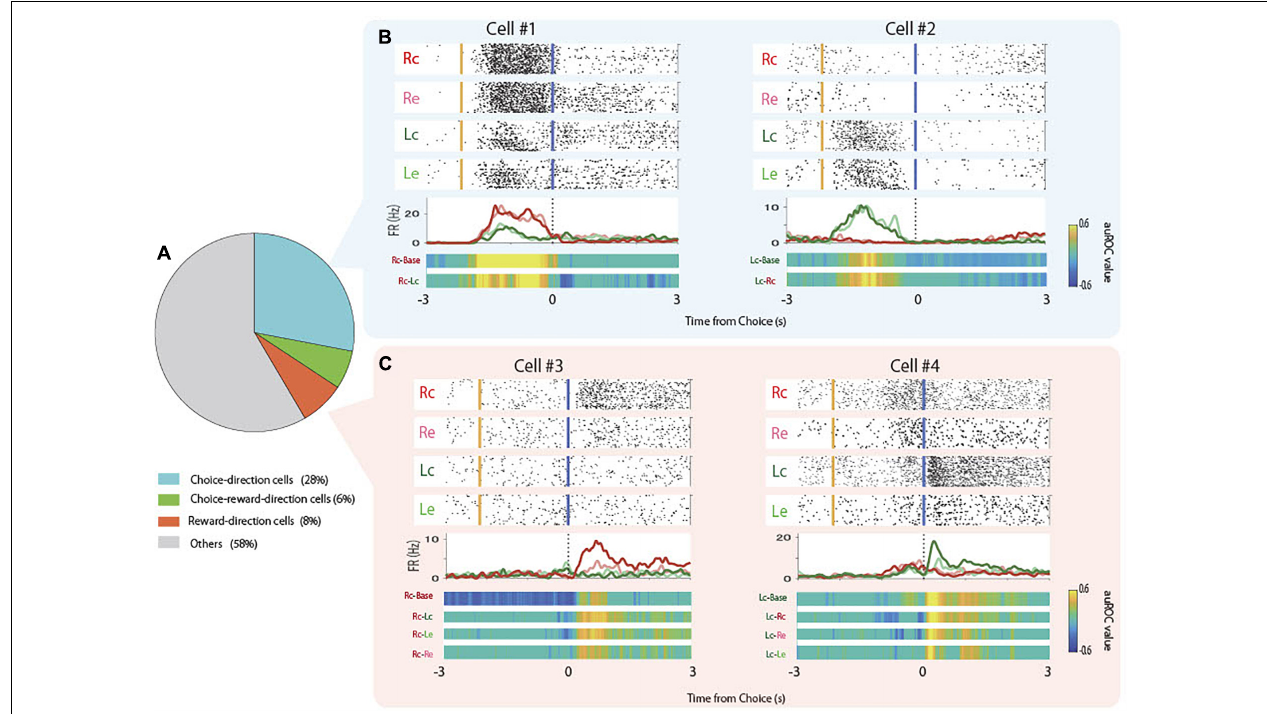
FIGURE 3 | Proportions and examples of choice-direction cells and reward-direction cells. (A) Proportion of choice-direction cells, reward-direction cells, and choice-reward-direction cells in the total pyramidal neurons. (B) Examples of firing patterns of choice-direction cells showed firing increments in Rc trials (Cell #1) and Lc trials (Cell #2). Top panels: raster plots for each task condition, yellow and blue lines indicate the times of tone stimulus on and choice response, respectively. Middle panels: PSTHs of Rc trials (red), Re trials (pink), Lc trials (green), and left erroneous (Le) trials (light green). Dashed lines indicate the times of the choice response. Bottom panels: auROC values of task conditions to be defined as choice-direction cells (permutation test, p < 0.05). (C) Examples of firing patterns of reward-direction cells that showed firing increments in Rc trials (Cell #3) and Lc trials (Cell #4) are presented as in panel (B) .